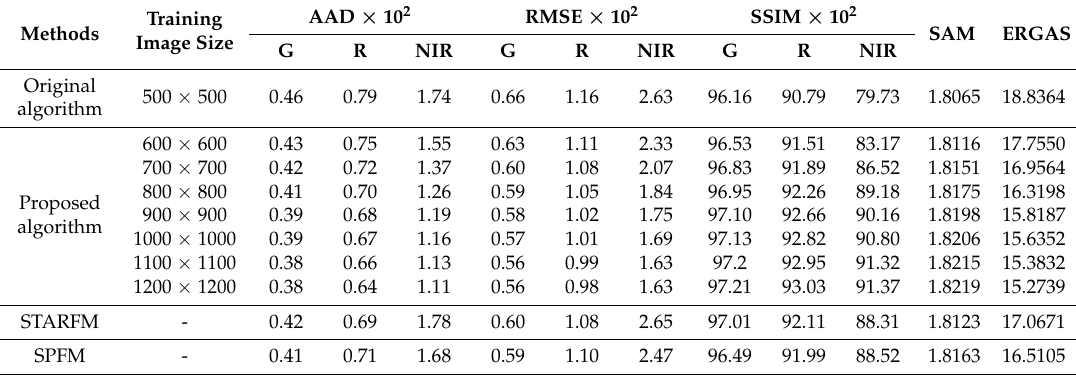
Table 2. Assessment indices of the spatially extended fusion for modeling reflectance on 24 May 2001 of the rural dataset.